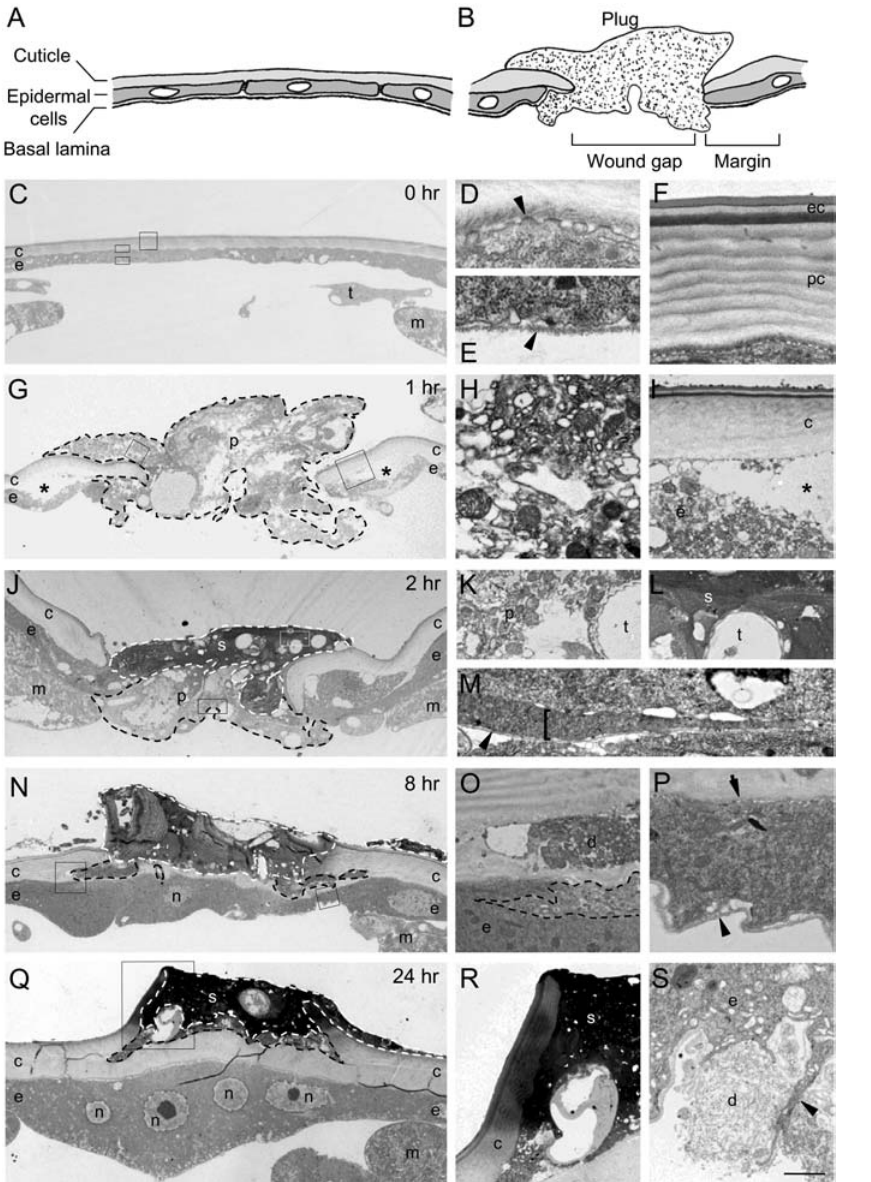
Figure 2. Ultrastructural Analysis of Punc- ture Wound